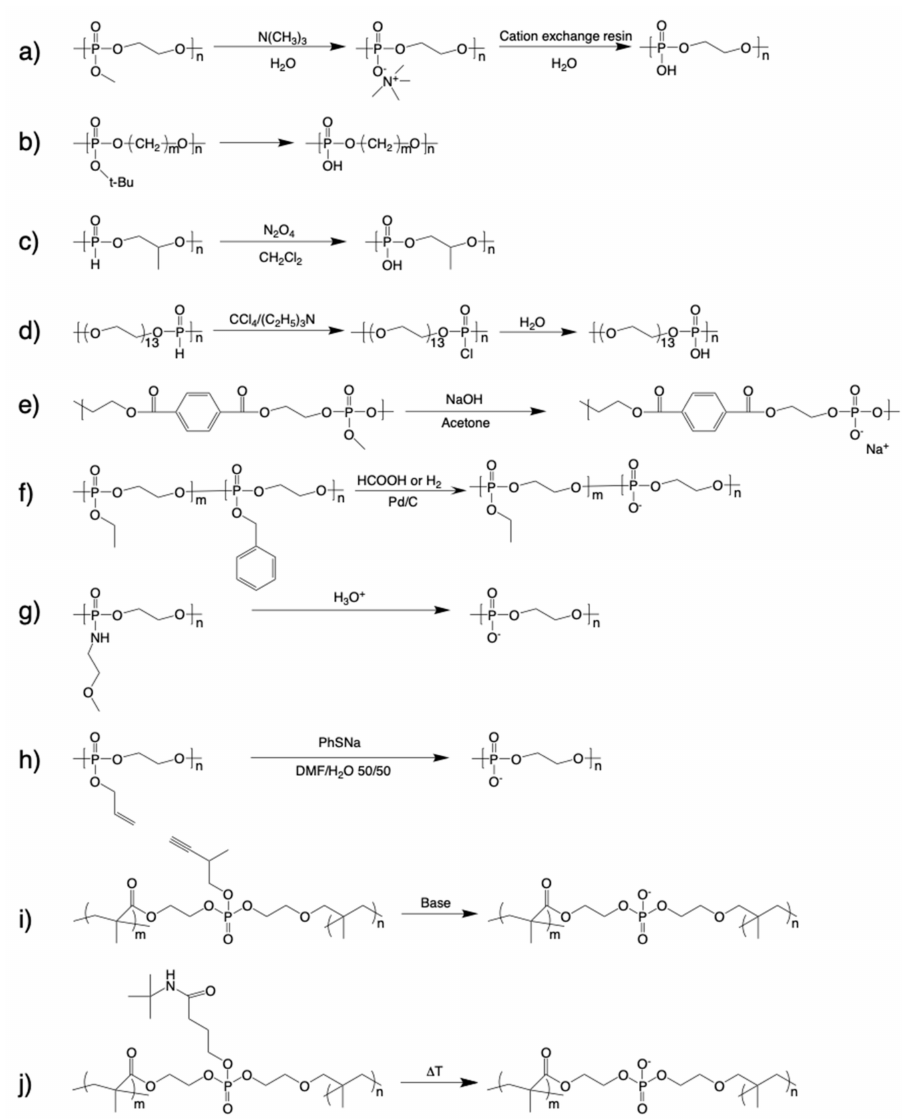
Figure 2. Synthetic routes to polyphosphodiesters